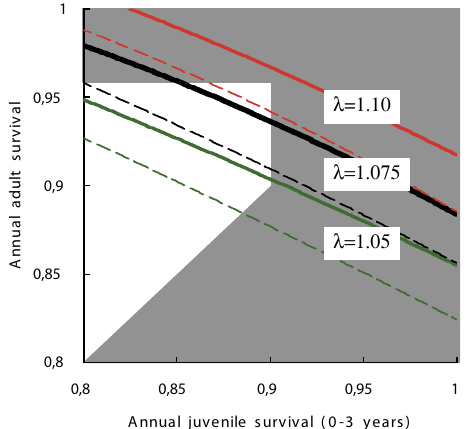
Fig. 10. Biological constraints delimit the maximum possible rate of increase in populations of grey seals. The shaded areas denote unlikely combina - tions of adult and juvenile survival rates. Any given point along the 6 lines shows a combination of adult survival and juvenile survival that produces a given growth rate (λ). The 2 uppermost lines are for λ = 1.10, the 2 lines in the middle for λ = 1.075 (as for the Baltic grey seals), and the lowest 2 lines show combinations that result in λ = 1.05. The stippled lines show combinations of adult and juvenile survival rates given that the mean annual pupping rate is 0.95. The bold full lines show the possible combinations given that the pupping rate is 0.75 (as suspected in the Baltic case).